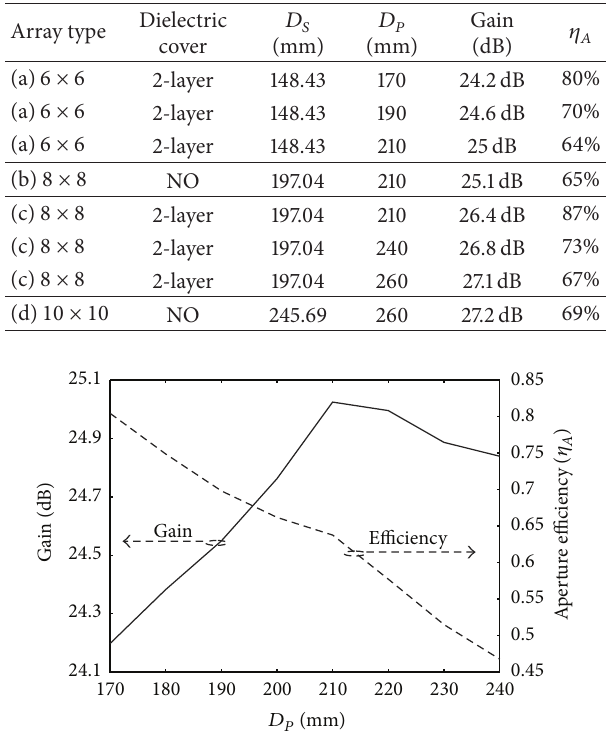
Figure 2: 6 × 6 array with two-layer dielectric cover: gain and effi- ciency as a function of 𝐷 𝑃 .